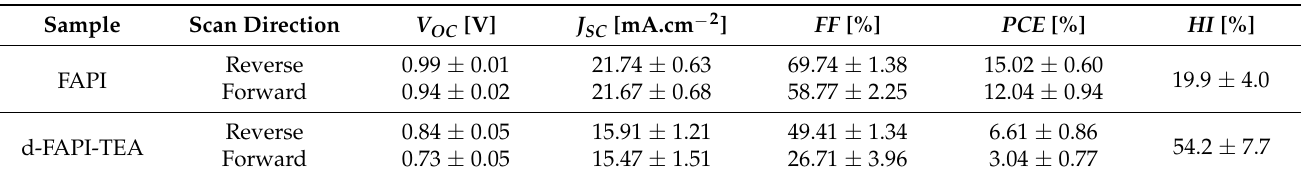
Table 2. Average photovoltaic J-V curve parameters, PCE, and HI with standard deviation of FAPI and